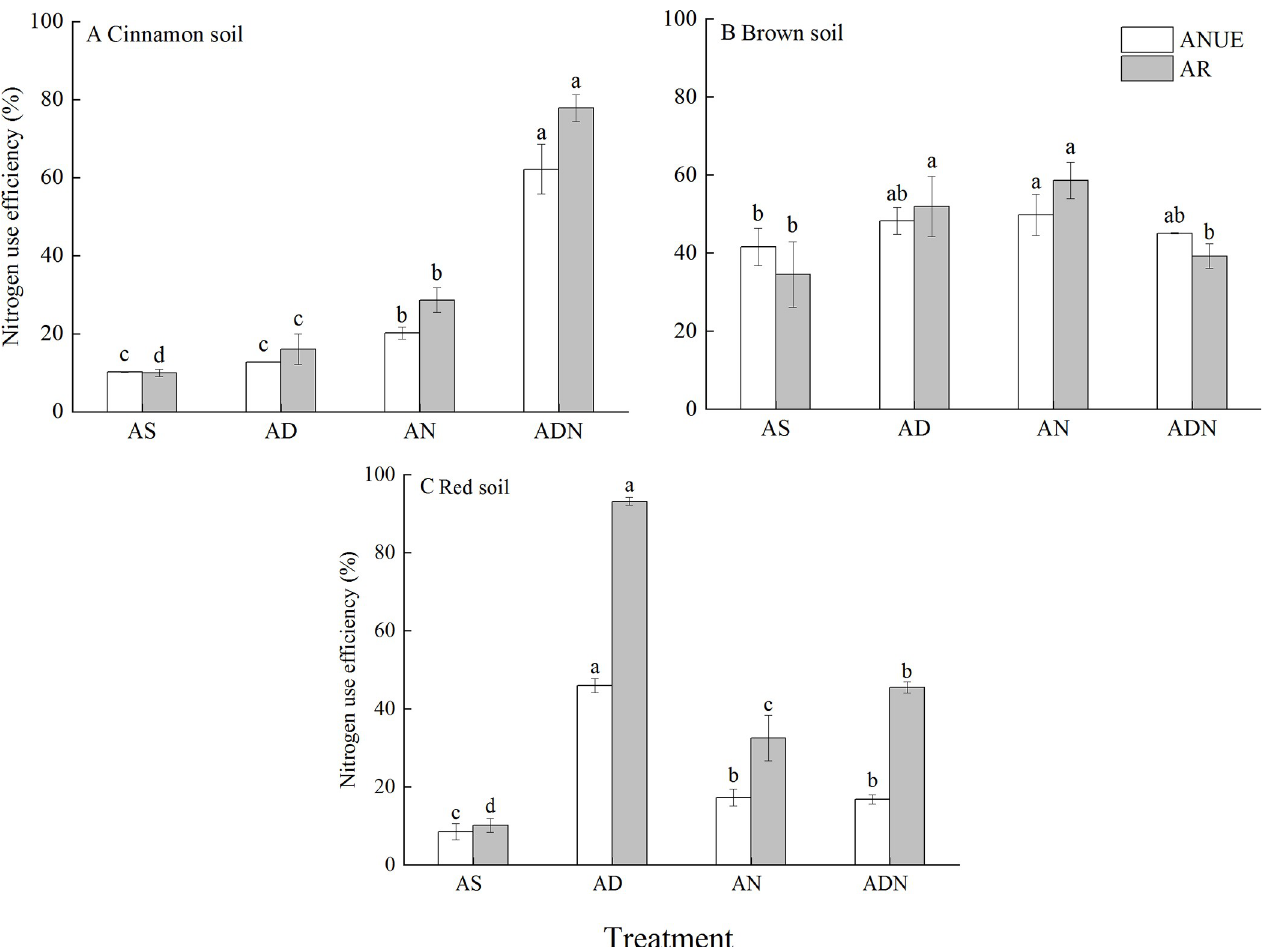
Fig 5. Nitrogen use efficiency (ANUE and AR) under different treatments in three soils. ANUE, agronomic nitrogen use efficiency; AR: Apparent nitrogen recovery. Treatment: AS, ammonium sulphate; AD, AS+3, 4-dimethylpyrazole phosphate (DMPP); AN, AS+nitrogen protectant (N-GD); ADN, AS+3, 4-dimethylpyrazole phosphate (DMPP)+nitrogen protectant (N-GD). Error bars represented standard deviations ( n = 3). Different letters indicate significant differences between different treatments at P < 0.05 by Duncan